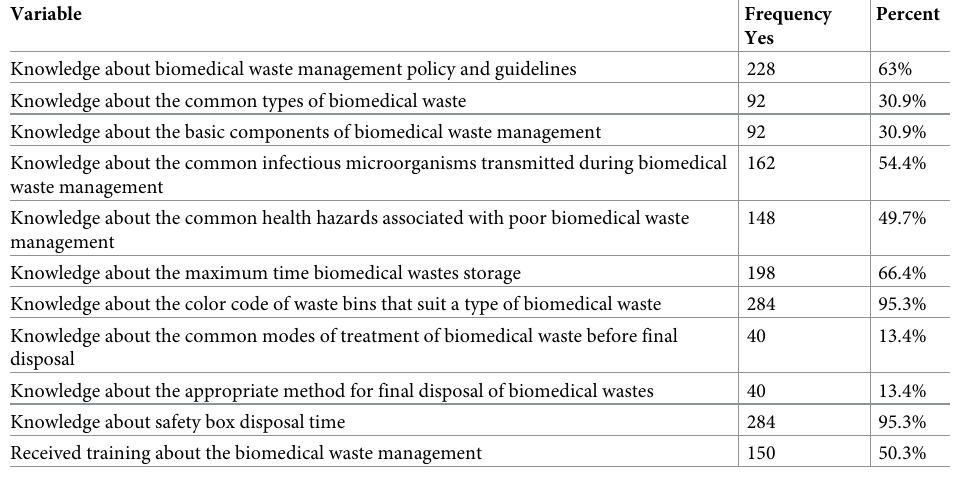
Table 2. Frequency of laboratory professionals of response for knowledge item questions for a study of biomedical waste management, Addis Ababa, Ethiopia (n =